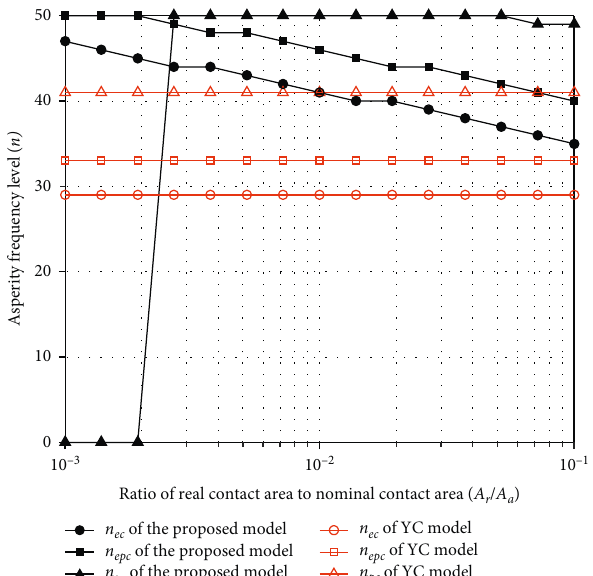
Figure 7: Comparison of the YC model and the proposed model on the critical asperity frequency levels with different nondimensional total real contact areas ( G � 2 . 5 × 10 − 9 m, D � 1 .